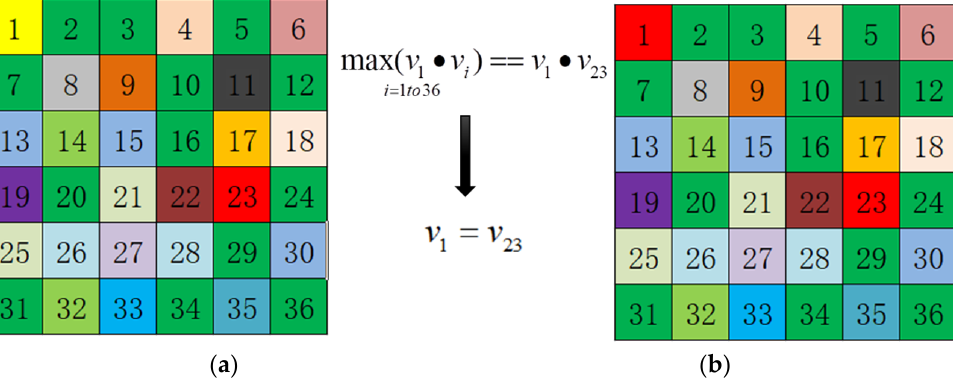
Figure 3. Schematic diagram of maximum weight replacement of the Lite Swin transformer. The number is the sequence number of the pixel, and the color is the feature value of the pixel, that is, v in Lite Swin transformer. ( a ) is the feature map before the Lite Swin transformer, and ( b ) is the feature map of the first pixel after being calculated by the Lite Swin transformer.